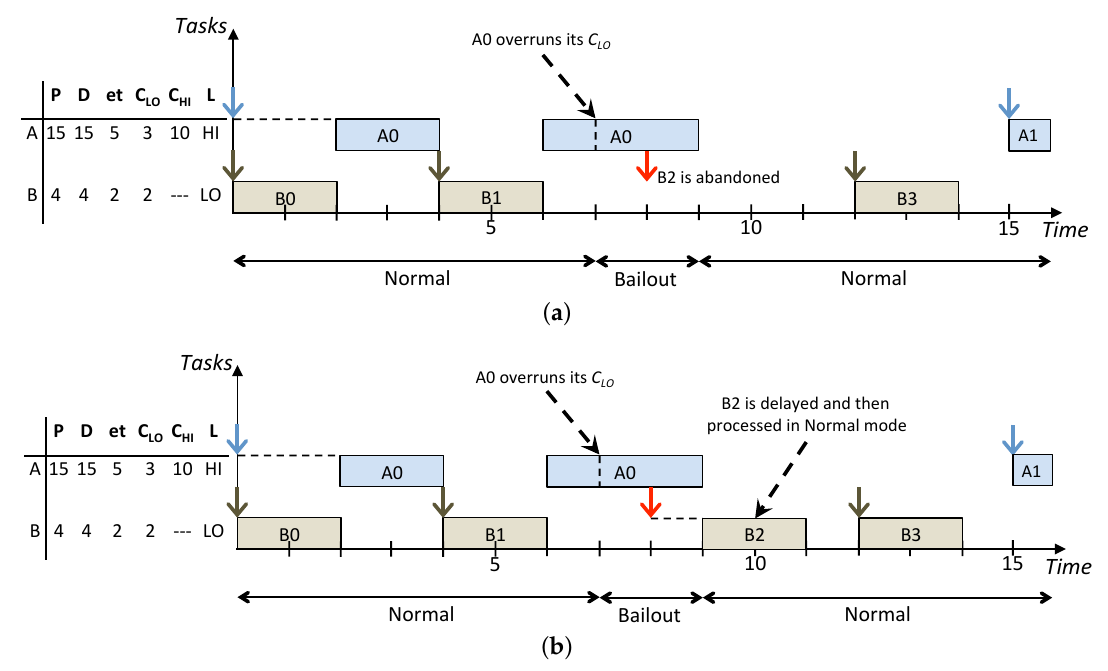
Figure 4. (Proof of Theorem 2) Example in which LBP successfully executes LO jobs that are abandoned by BP: ( a ) BP abandons LO jobs that are not released in Normal mode; and ( b ) LBP provides a delayed execution for job B 2